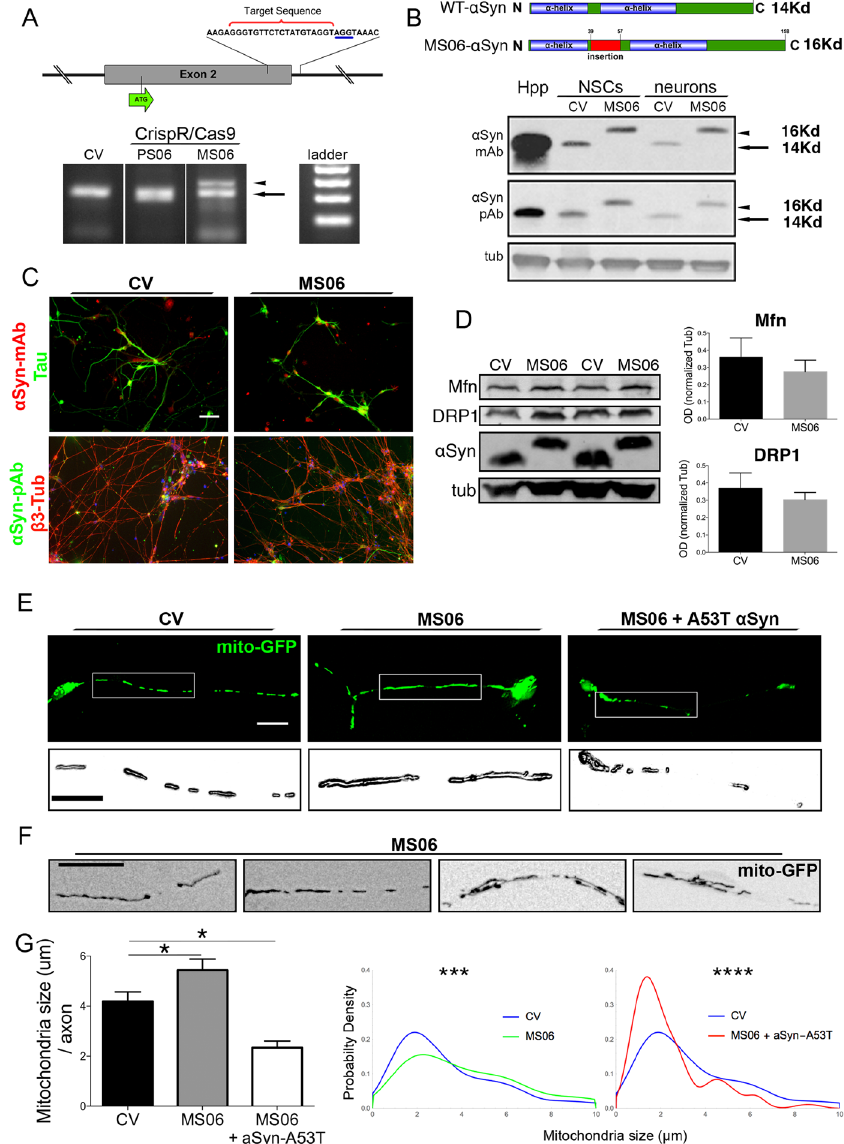
Figure 5. α Syn α -helix domain disruption increases mitochondrial size in human neurons. ( A ) Upper panel: Scheme of α Syn exon 2 sequence and guide RNA target sequence (red bracket) followed by the PAM sequence (blue) for CRISP-R/Cas9-mediated DNA cut. Lower Panel: Genomic PCR screening for insertions or deletions in CV hiPSC lines after CRISP-R/Cas9 edition. Two clones, PS06 (smaller size band) and MS06 (larger size band, arrowhead) are shown together with WT amplification (arrow). ( B ) Western blots from homogenates of mouse hippocampus (Hpp) and human neural stem cells or differentiated neurons from control or MS06 using two different antibodies against α Syn show a higher molecular weight α Syn in MS06 due to the insertion without downstream changes. Monoclonal (antigen aa 15–123) and polyclonal (antigen aa 111–131) anti- α Syn. ( C ) α Syn expression in terminally differentiated neurons derived from hiPSC-CV (control) or MS06. Monoclonal or polyclonal α Syn immunofluorescent staining in MS06 neurons compared with CV. Scale bar, 50 μ m. ( D ) Western blot from total protein extract from CV and MS06 neuron homogenates. Mfn and Drp1 were quantified and normalized to tubulin as control (n = 3 independent experiments). ( E ) Representative images of neurons transfected with mito-GFP for mitochondrial morphology analysis of hiPSC-CV, MS06 clone, or MS06 plus A53T α Syn. Inset: magnification of axonal mitochondria. Scale bar, 30 μ m, inset, 20 μ m. ( F ) Representative images obtained from MS06 differentiated neurons showing abnormal elongated, aggregated, and interconnected axonal mitochondria. ( G ) Significant increase in mean mitochondrial size per axon was observed in MS06 neurons when compared to CV-derived neurons, while a reduction in size was observed upon A53T α Syn overexpression in MS06 neurons. Data is represented as mean ± SEM (n = 25 axons per condition from 2 independent experiments). One-way ANOVA followed by Dunnett’s post-test, * p < 0.05. Pooled mitochondria probability density by size distribution plots between MS06 and CV or A53T α Syn transfected MS06 and CV. Kolmogorov-Smirnov test performed for each comparison, *** p < 0.001, **** p < 0.0001 (n > 280 mitochondria per condition from 2 independent